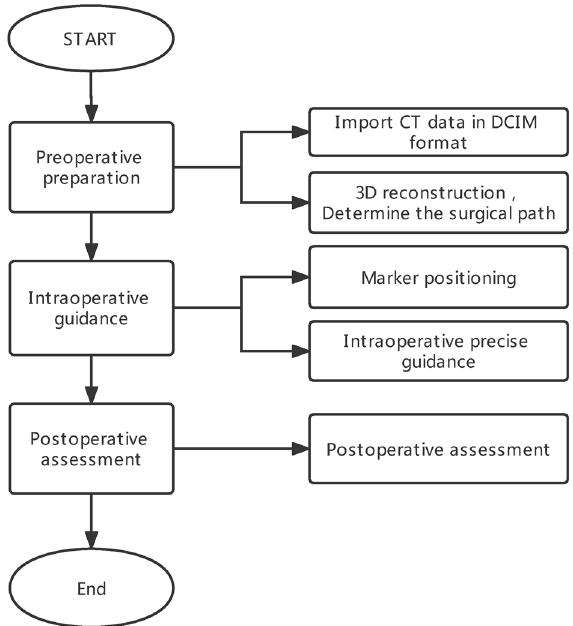
Figure 2. The workflow of the whole